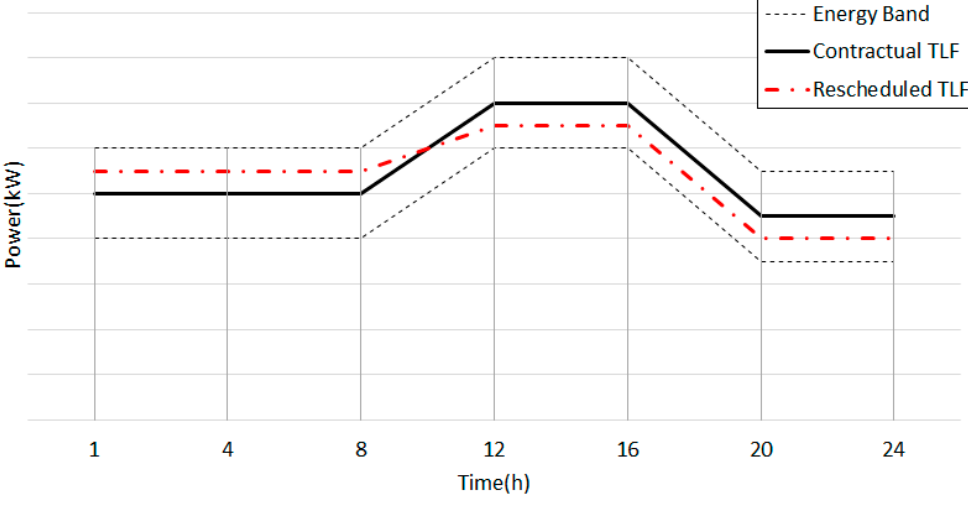
Figure 3. Structure of TLF energy band contracts.